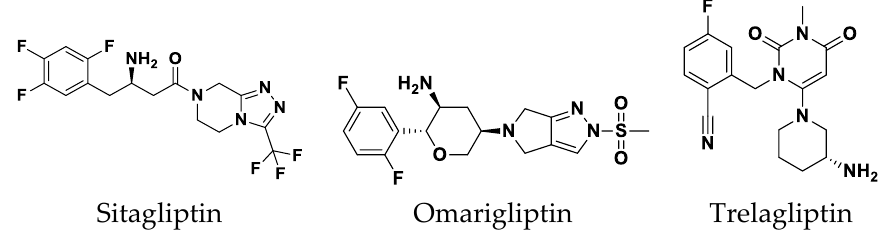
Figure 5. Two-dimensional structural representation of investigated gliptin drug members.